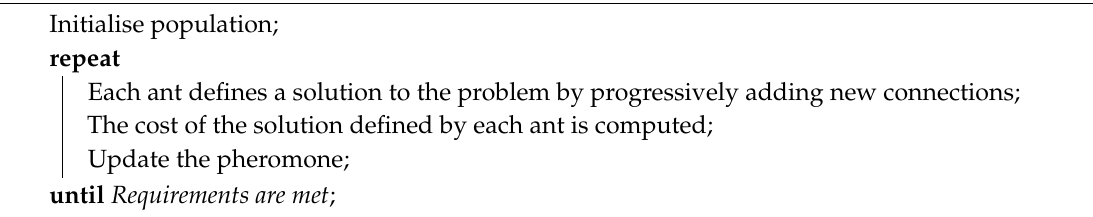
Algorithm 1: Artificial ants algorithm